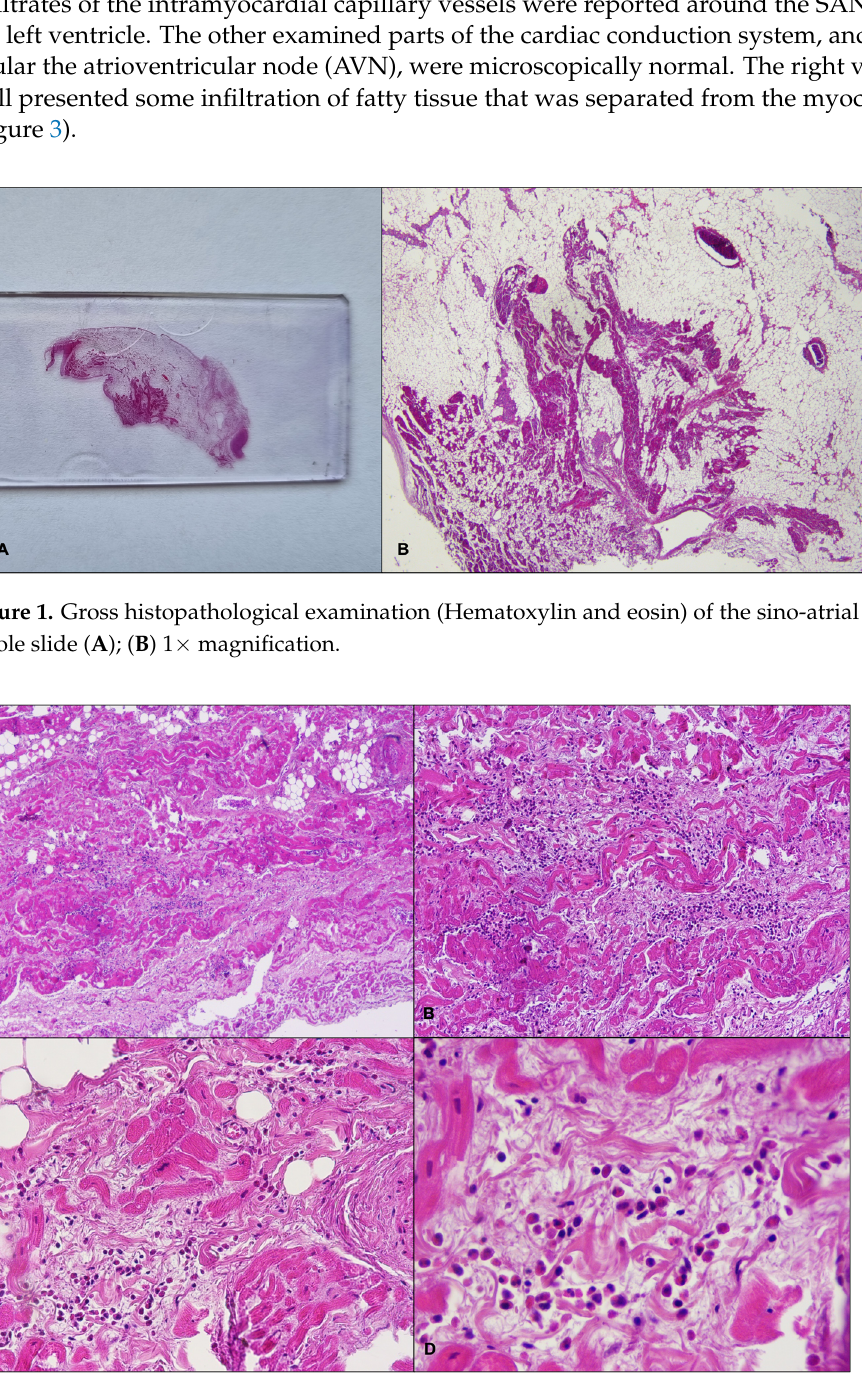
Figure 2. Histopathological examination (hematoxylin and eosin) of the sino-atrial node shows inter- stitial fibrosis and eosinophilic inflammatory infiltrate: ( A ) 4 × magnification; ( B ) 10 × magnification; ( C ) 20 × magnification; ( D ) 40 ×